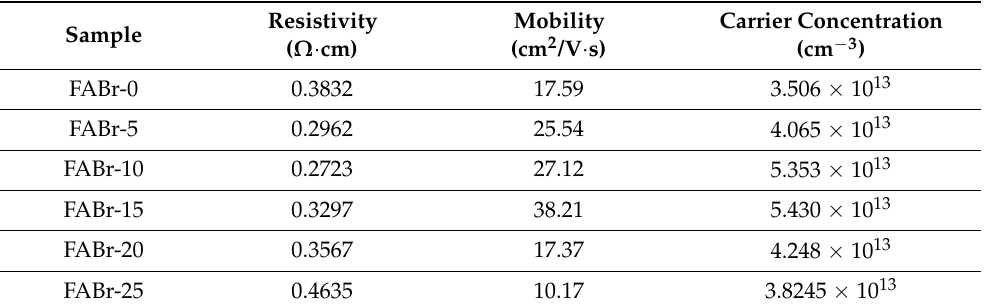
Figure 3. Characteristics of films of mixed-anionic perovskites according to FABr concentration. ( a ) XRD pattern, ( b ) UV-vis absorption spectrum in the deep-UV region, ( c ) photoelectric characteristics. Table 1. Comparison of resistivity, mobility, and carrier concentration of thin films according to the amount of FABr